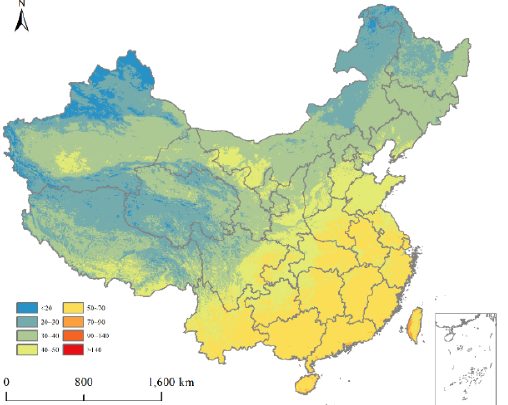
Figure 3. Spatial distributions of the predicted nationwide monthly average GOCs in November 2018 based on the GLM.